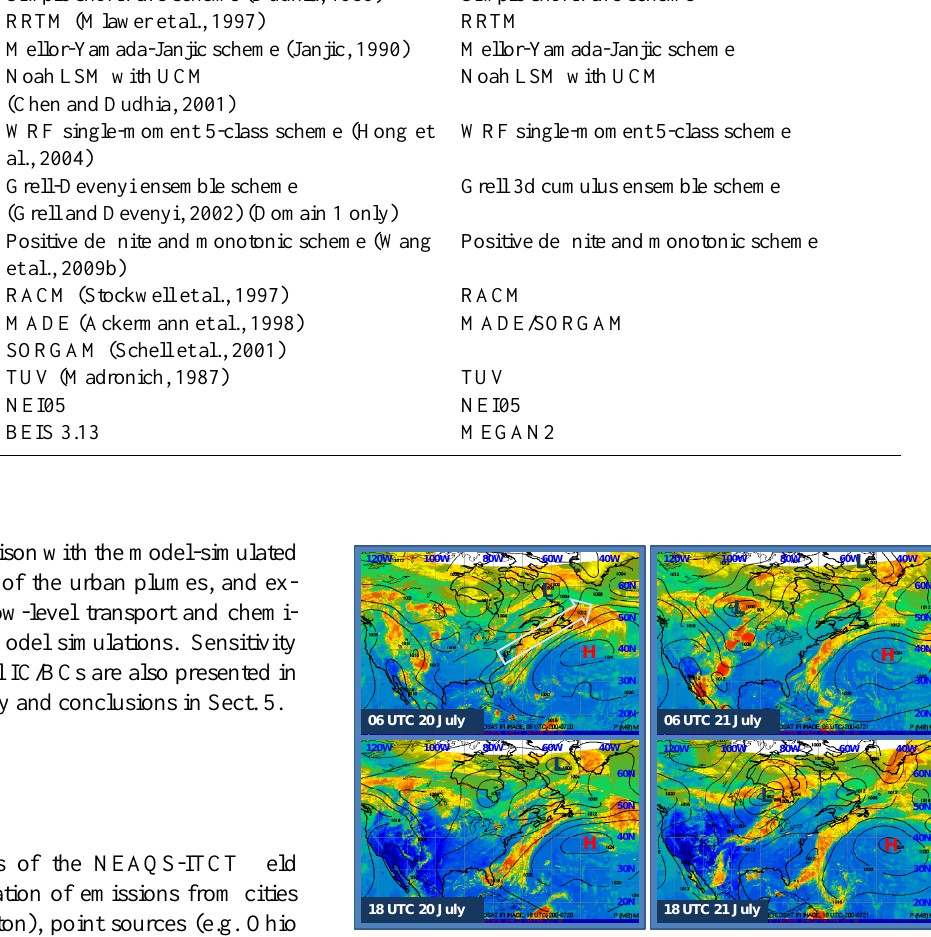
21 July flights measured the chemical composition of